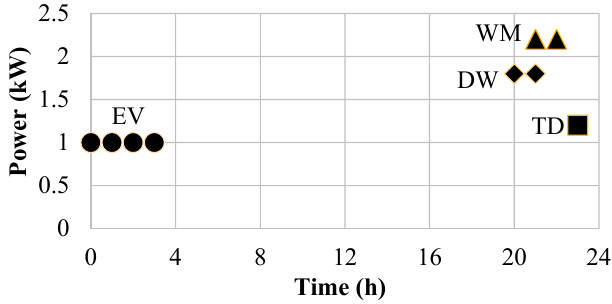
Figure 9. Load scheduling according to the familiar habits. EV: electric vehicle; WM: washing machine; TD: tumble dryer; DW: dishwasher.